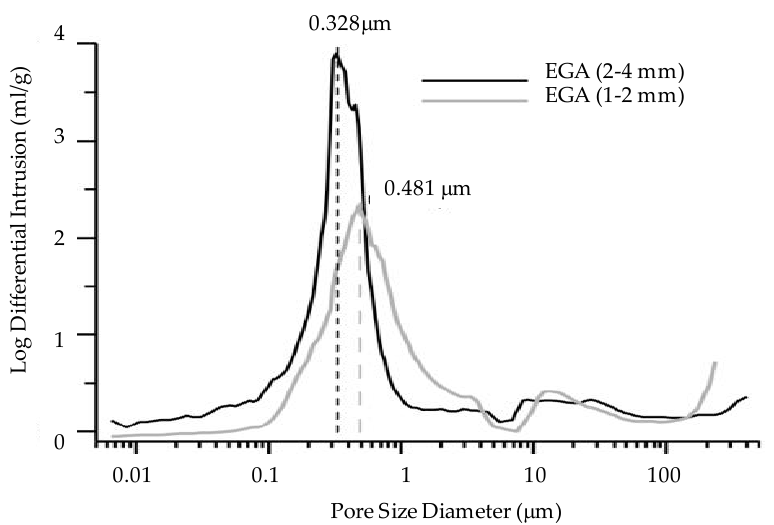
Figure 4. Pore size distribution of the EGA.